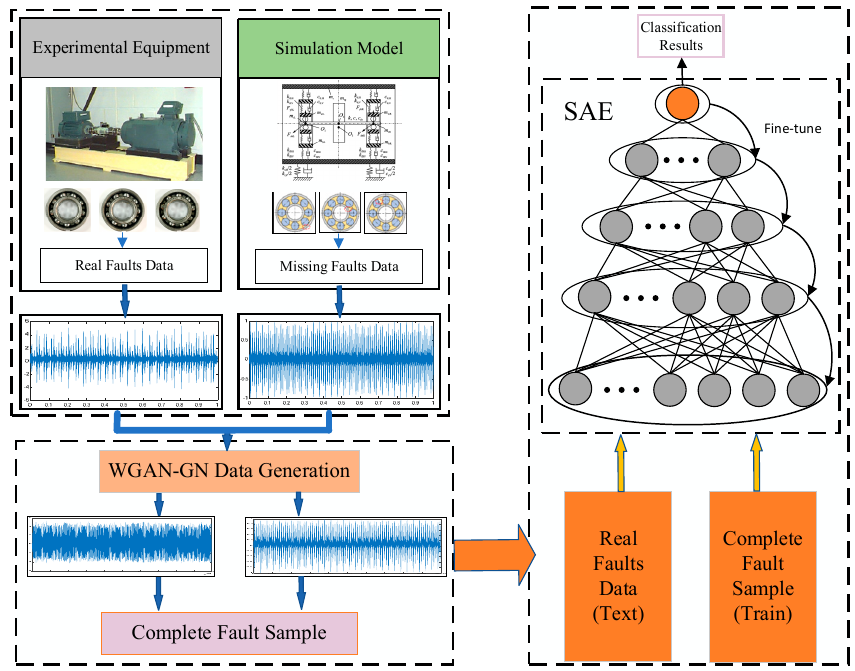
Figure 6. Fault diagnosis model design.